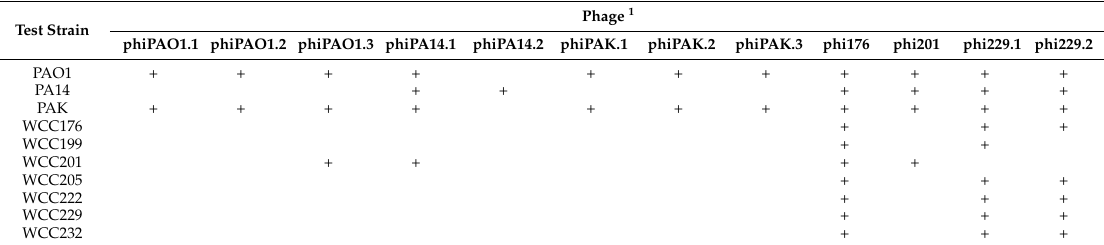
Table 3. Host range of individual phages isolated from the round-30 cocktail.